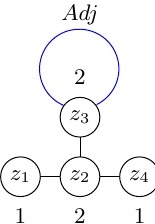
Figure 12 . P (4) quiver with B 3 global symmetry, b = 0, dim M H [2 ; 1 2 ]